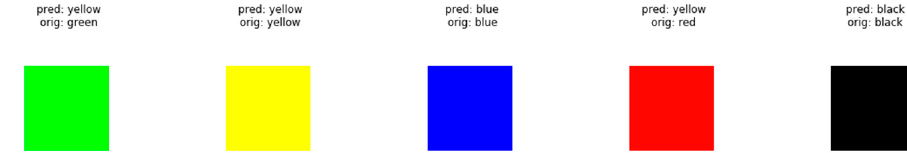
Figure 7. The effectiveness of inference for 5 epochs.